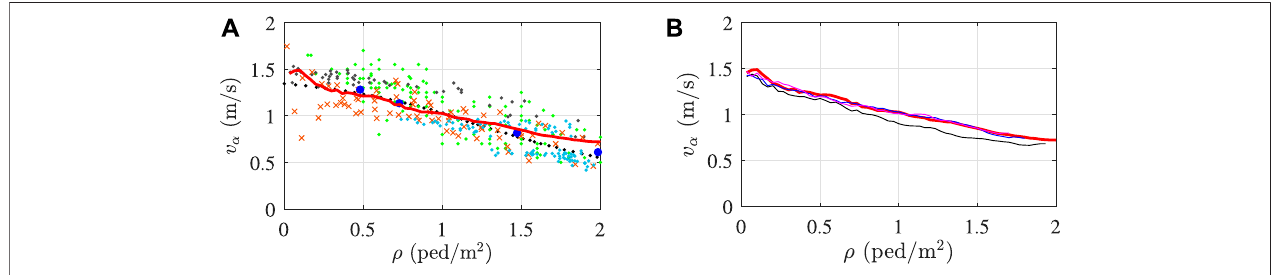
FIGURE8|(A) Comparisonbetweenthesimulatedspeed-densityrelation(redcurve)andexperimentalmeasurementsofpedestrian fl ows.Blackdots:Weidmann (1993), green dots: Oeding (1963), grey dots: M (cid:2) ori and Tsukaguchi (1987), orange crosses: Older (1968), light blue dots: Seyfried et al. (2005), blue circles: Fruin (1987) (B) Simulated speed-density relations obtained considering different footbridge width: 3.0 m (red curve), 2.5 m (black curve), 4.5 m (blue curve) and 7.0 m (magenta curve).